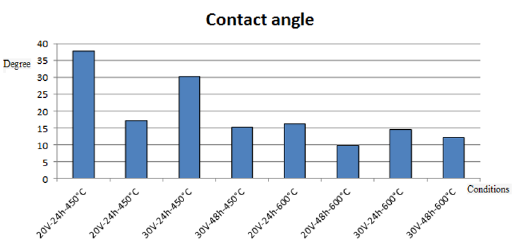
fluids, cells and tissues 40 . According to Elias et al. 41 , the adsorption behavior and protein adhesion on the implant surface depends on the surface properties. On hydrophobic surfaces, traces of antibodies reduce cell adsorption.